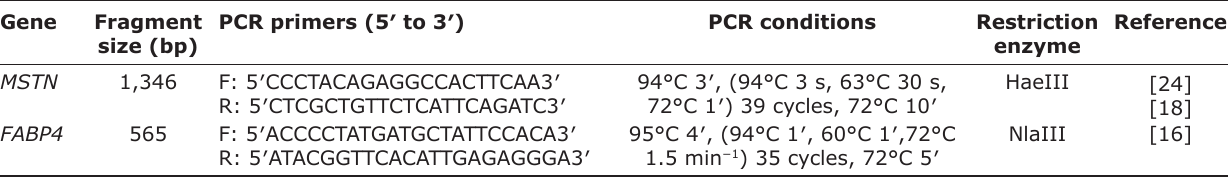
Table-1: Fragment size, PCR primers and conditions, and restriction enzymes used in the analysis of MSTN and FABP4 polymorphisms. Gene Fragment PCR primers (5′ to size (bp)